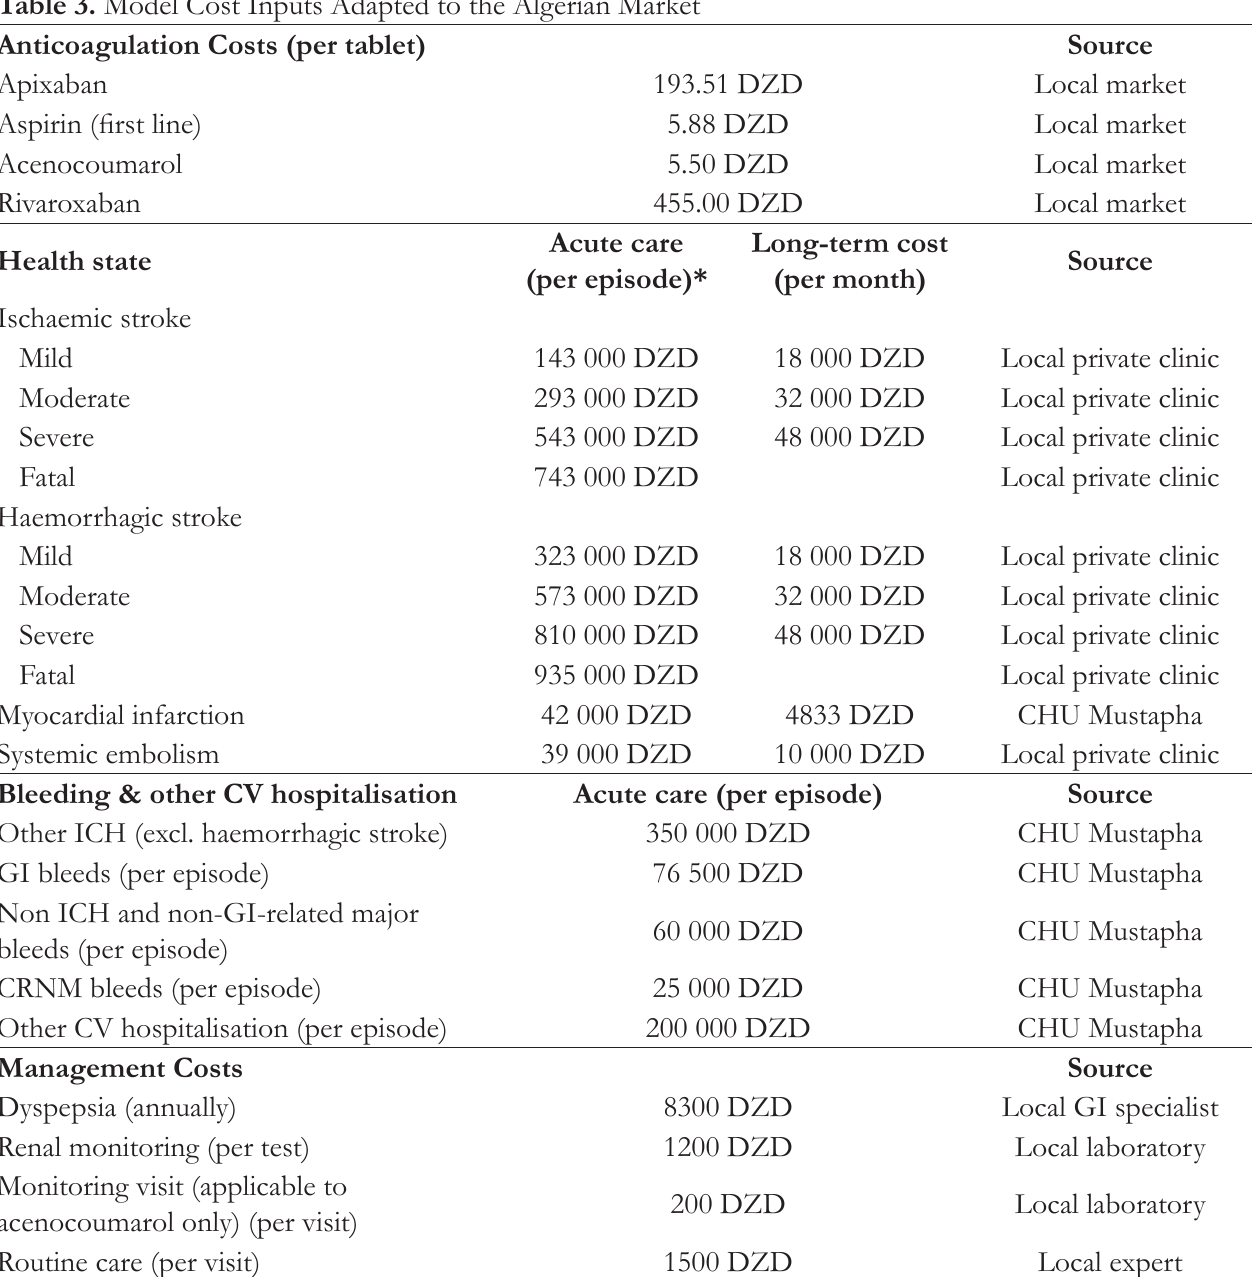
Table 3. Model Cost Inputs Adapted to the Algerian